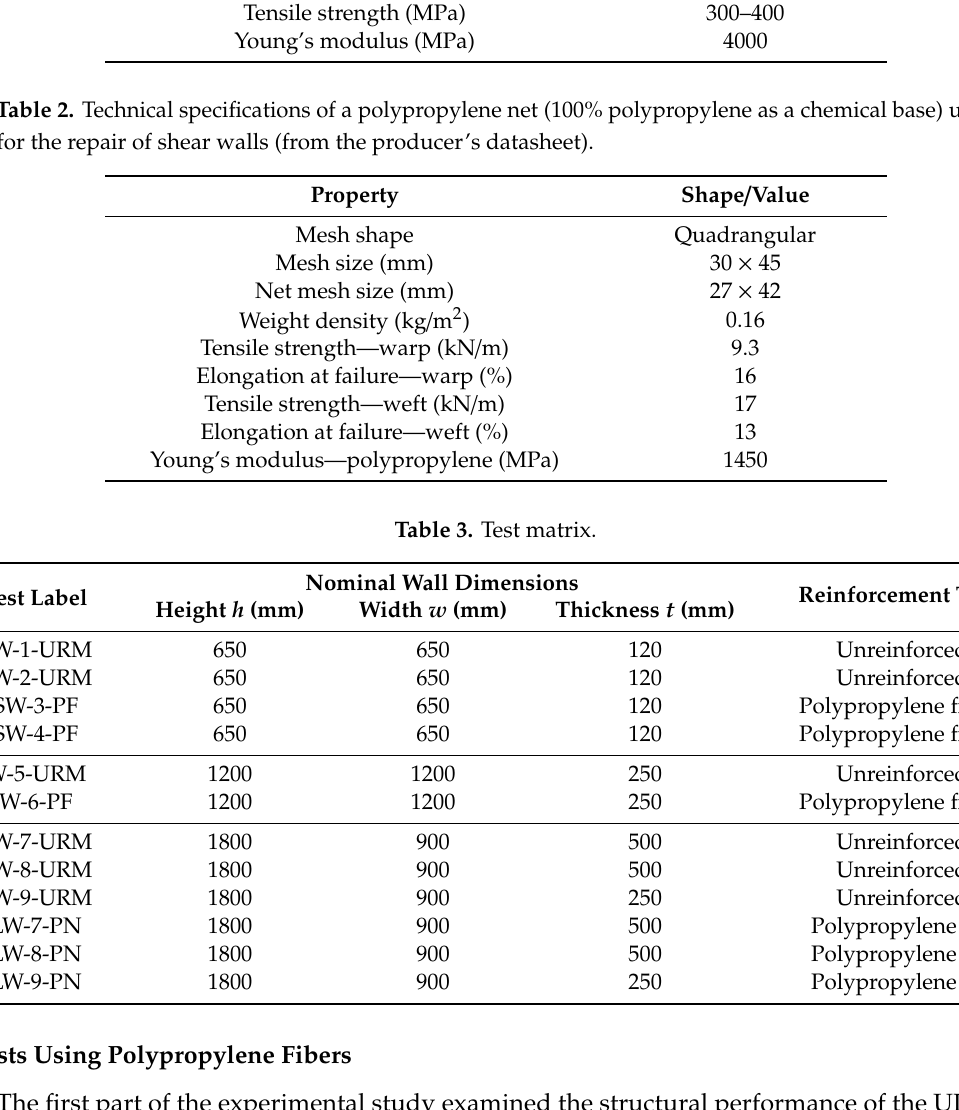
Table 2. Technical specifications of a polypropylene net (100% polypropylene as a chemical base) used for the repair of shear walls (from the producer’s datasheet).